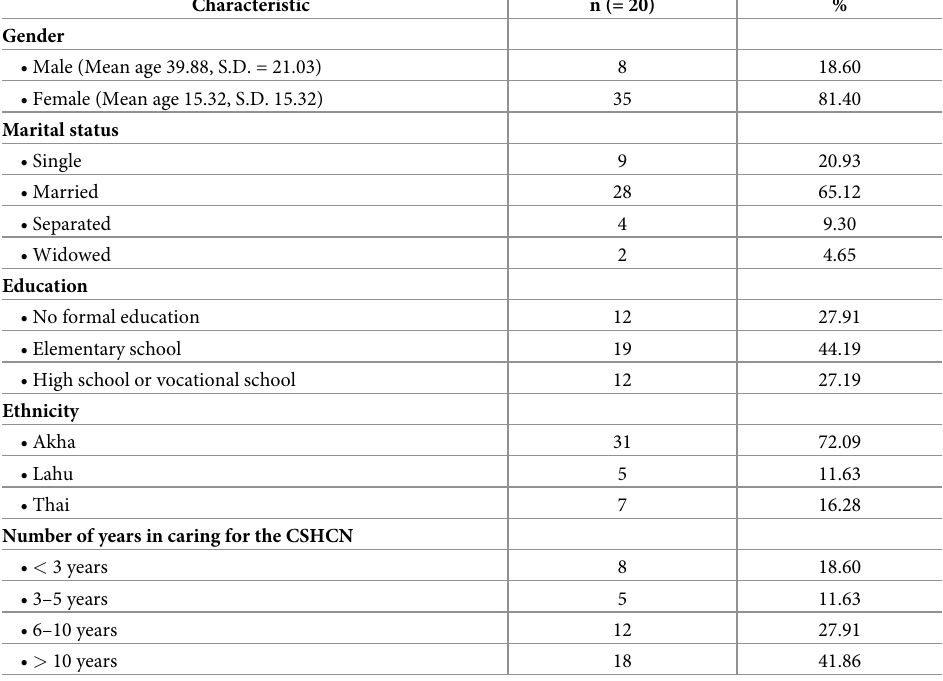
Characteristic n (= 20) %